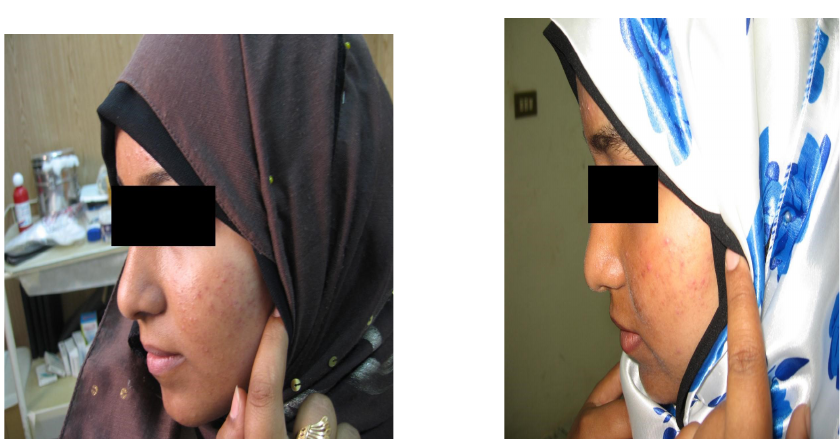
Fig (12-A) A case of acne GAAS III before the treatment Fig (12-B) GAAS I after 6 weeks